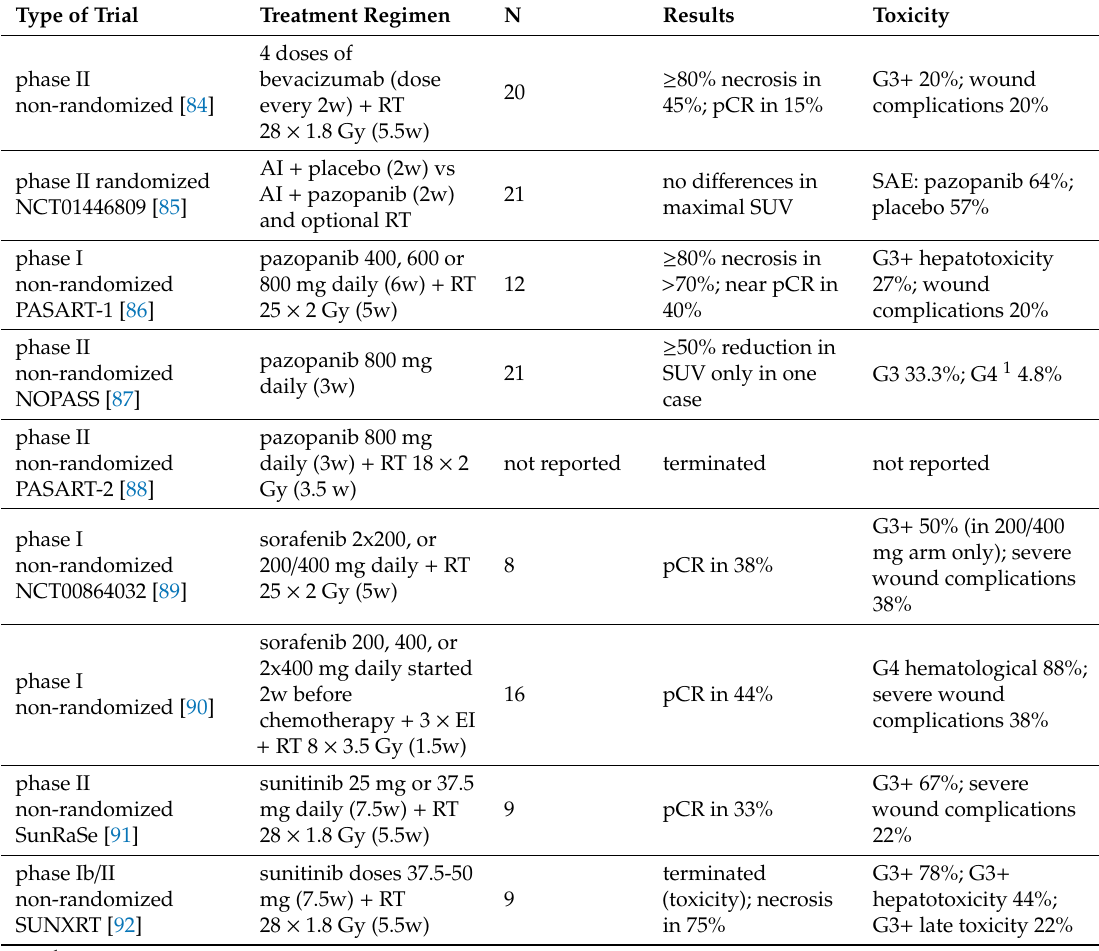
Table 4. Neoadjuvant targeted therapies in soft tissue